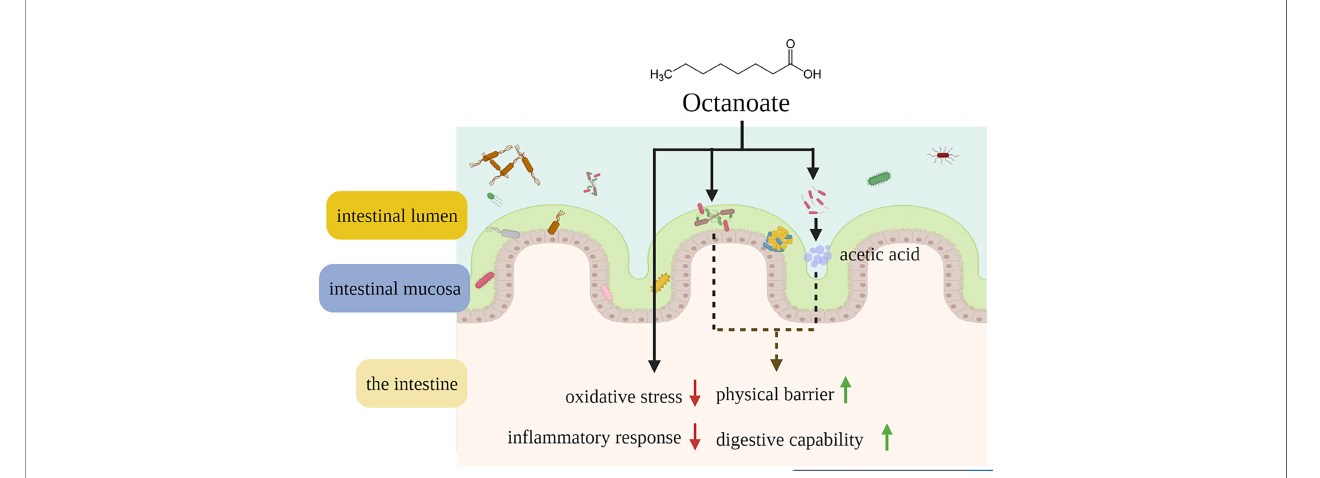
FIGURE 6 | Schematic representation showing that dietary octanoate repaired intestinal physical barrier damage, oxidative stress, in fl ammatory response and microbial